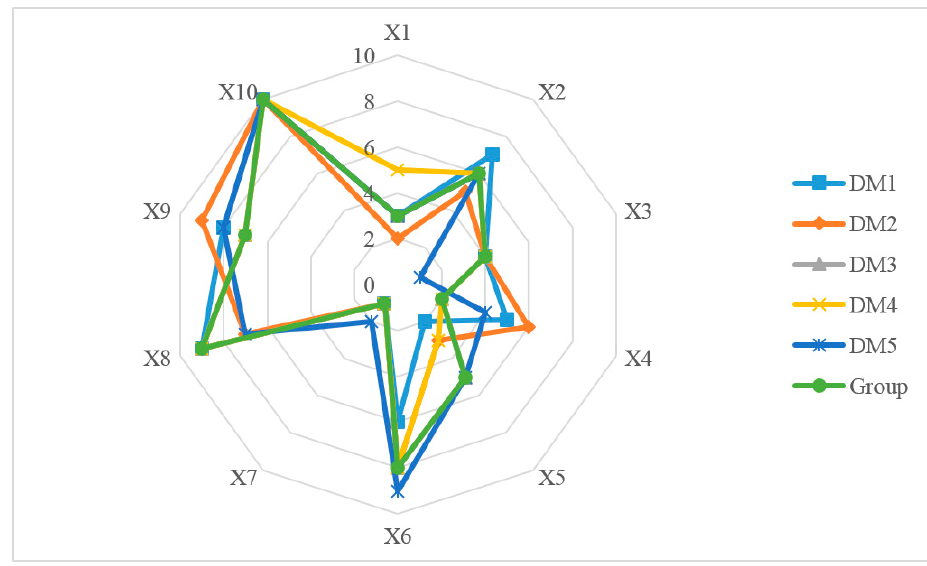
Figure 9. The individual ranking and group ranking for 10 mobile medical APPs based on UMLDM- EW.